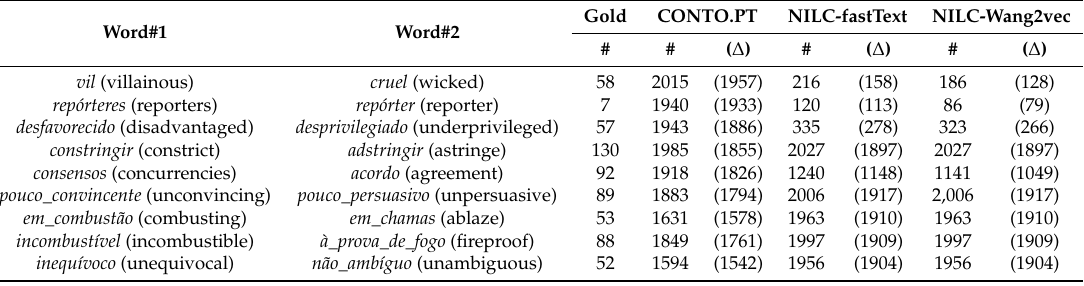
Table 16. Word pairs with higher rank difference ( ∆ ) in procedures using three different databases and gold score in RareWords.